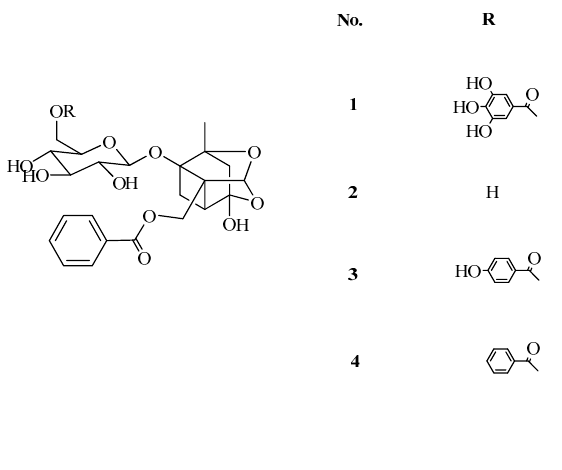
Figure 1. Chemical structures of galloylpaeoniflorin ( 1 ), paeoniflorin ( 2 ), mudanpioside C ( 3 ) and benzoylpaeoniflorin ( 4 ).